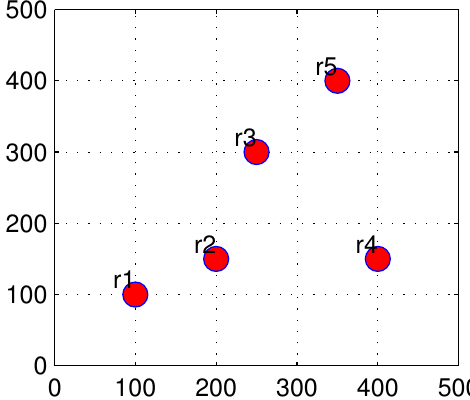
Figure 3. An example of the solution